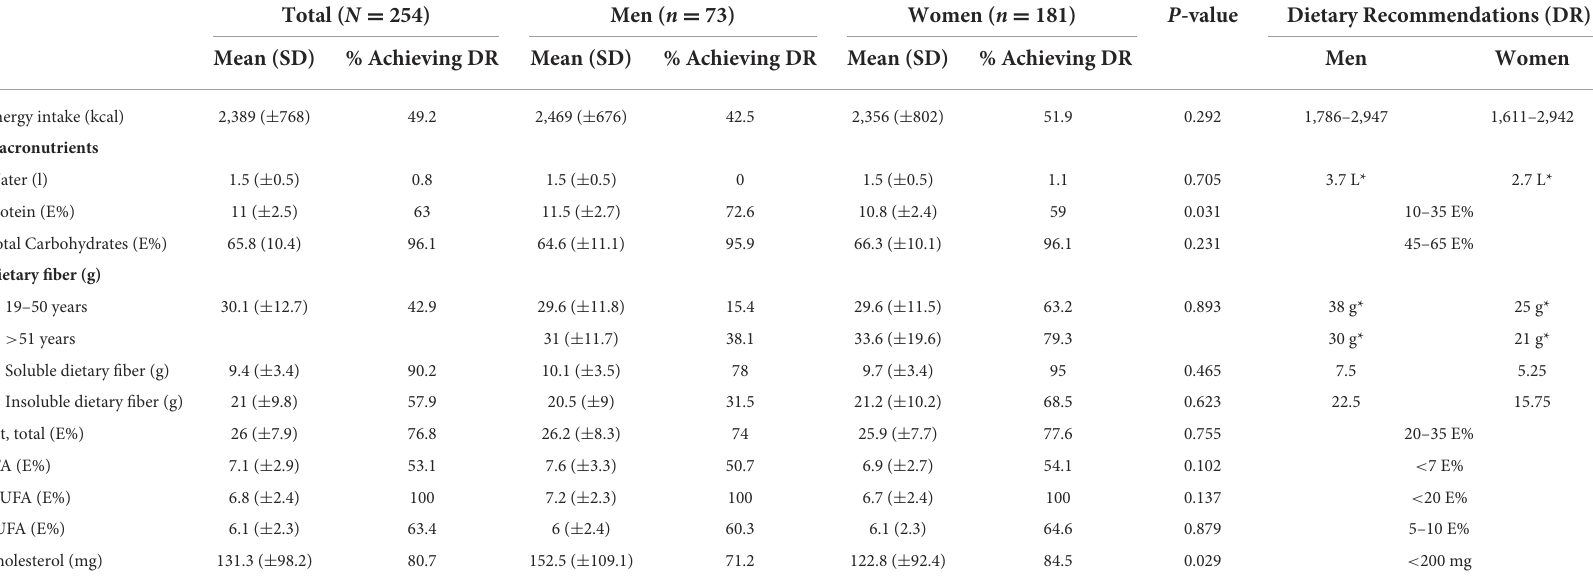
TABLE 4 Usual energy and macronutrients intake by sex and comparison with the IOM